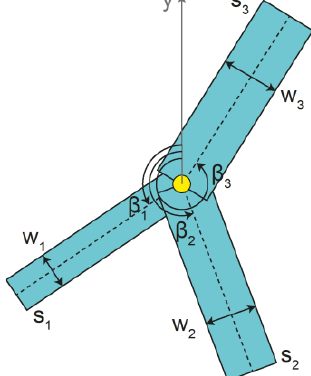
Figure 1. Example for a junction point with n seg = 3 outgoing segments. Each segment s j is characterized by its width w j and its direction β j